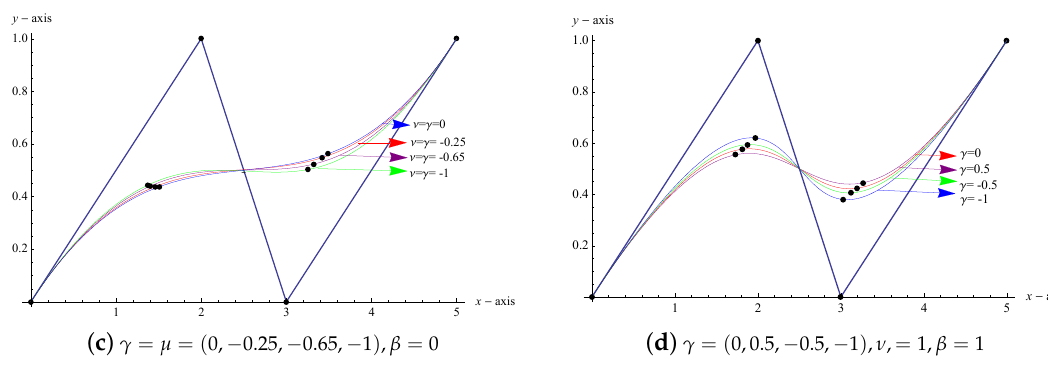
0.1, 0.6 ) , γ = − − 0.25, 0.65, 1 ) , β = 0; ( d ) γ = − − −